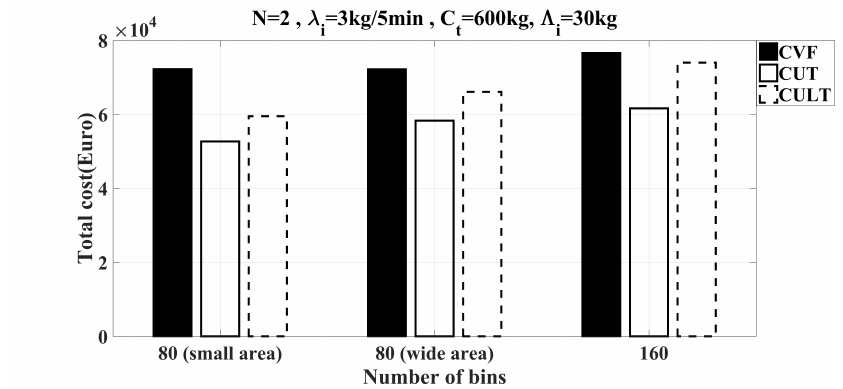
Figure 20. Cost: bin count as the number of bins increased.